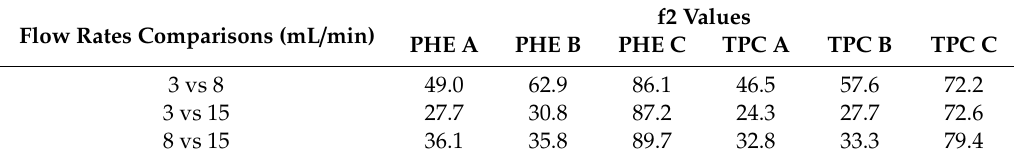
Table 4. Similarity factor f2 pairwise comparison of phenylephrine and tropicamide release profiles. Intra-formulations comparison at di ff erent flow rates.